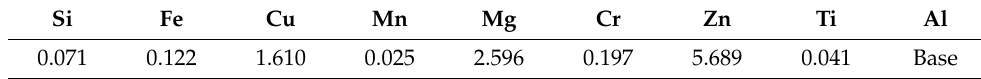
Table 1. Chemical composition (wt.%) of AA7075-T651 alloy.